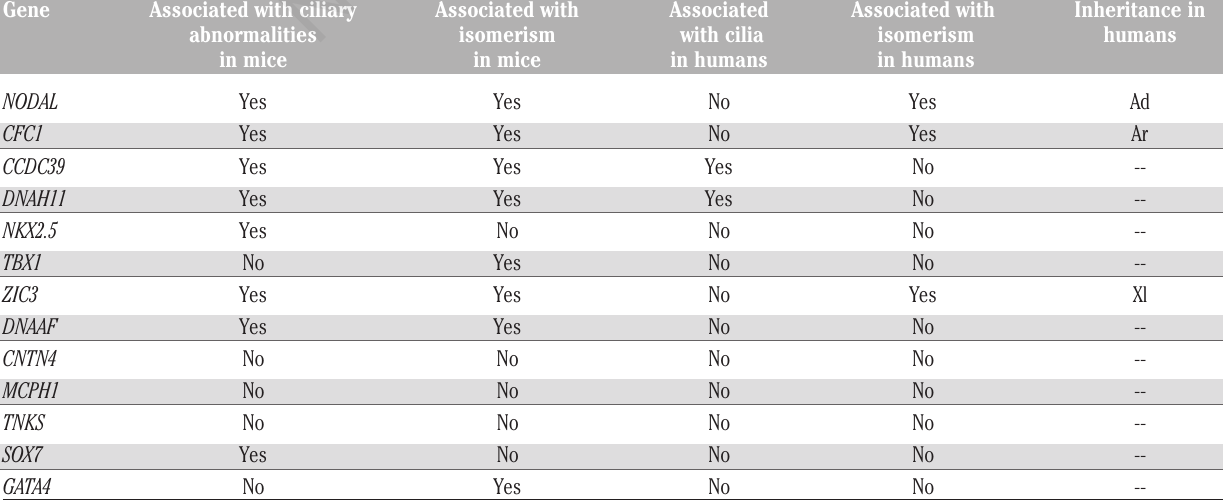
Table 3. Genes identified in cohort and their association with isomerism and ciliary dyskinesia. Gene